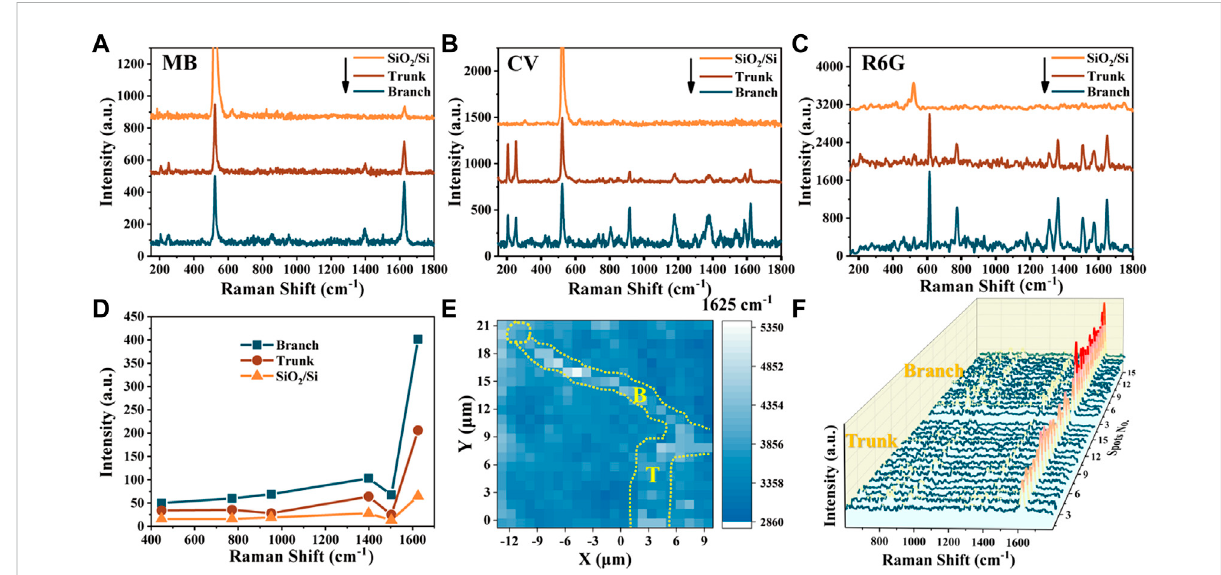
FIGURE 6 Raman spectra of (A) MB, (B) CV, and (C) R6G deposited on trunks and topological branches of ZnSe nanowire substrates; all concentration is 10 − 5 M. (D) Intensities of the peaks of MB (10 − 5 M) deposited on the trunks, topological branches, and blank SiO 2 /Si substrate. (E) Spatial mapping